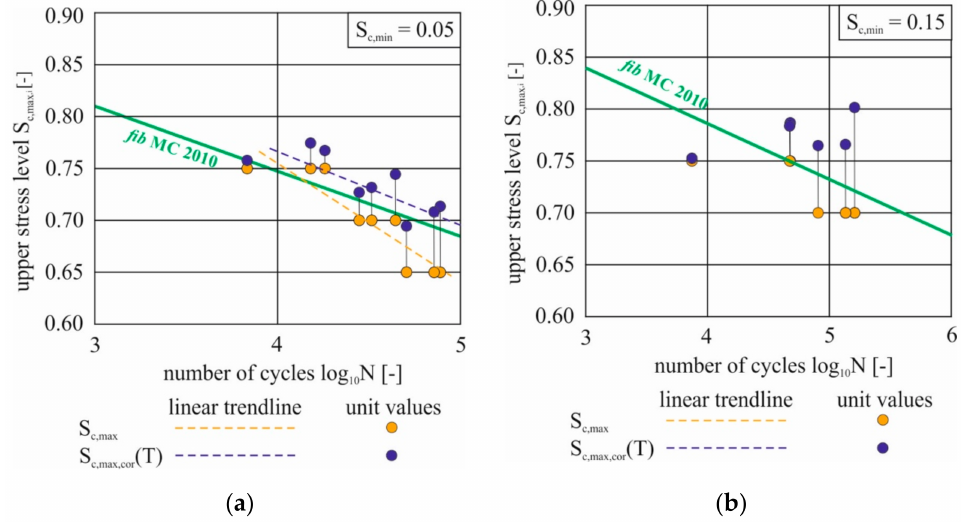
Figure 8. Achieved numbers of load cycles in relation to the initial planned upper stress level S c,max as well as the corrected upper stress level S c,max,cor ( T ) according to Equations (4) and (5) with corresponding linear trend lines; f = 10 Hz, S c,min = 0.05 ( a ) and 0.15 ( b ),